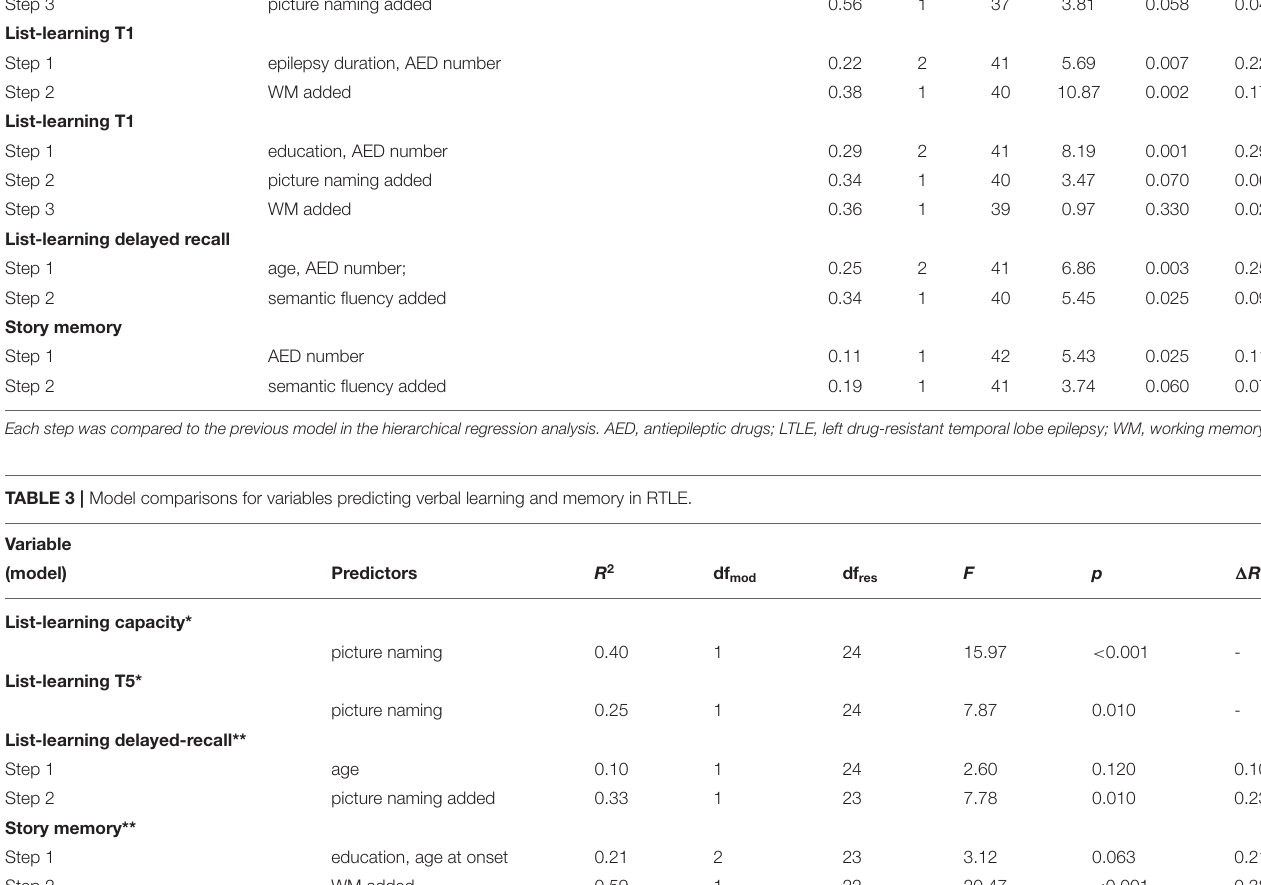
0.04. When controlling for education years and picture naming,